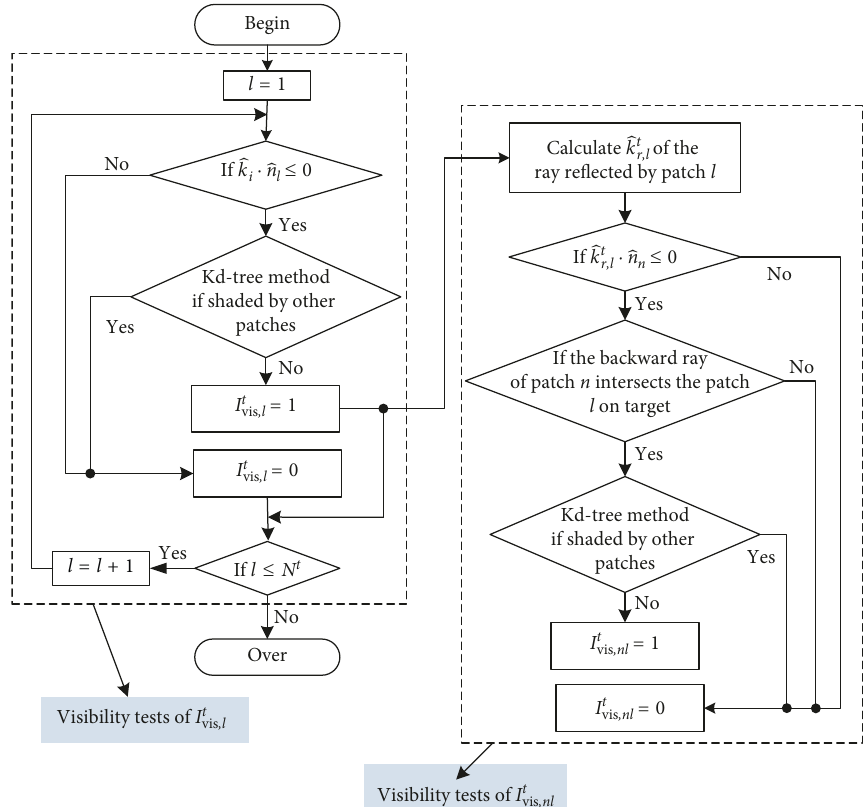
Figure 3: Visibility tests of I t